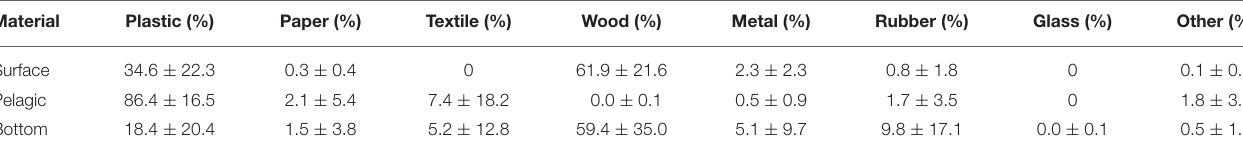
TABLE 2 | Percentage composition of marine litter floating at surface (by volume), or as bycatch in pelagic and bottom trawls (by weight) for the period 2010–2016, presented as mean per year ± SD.